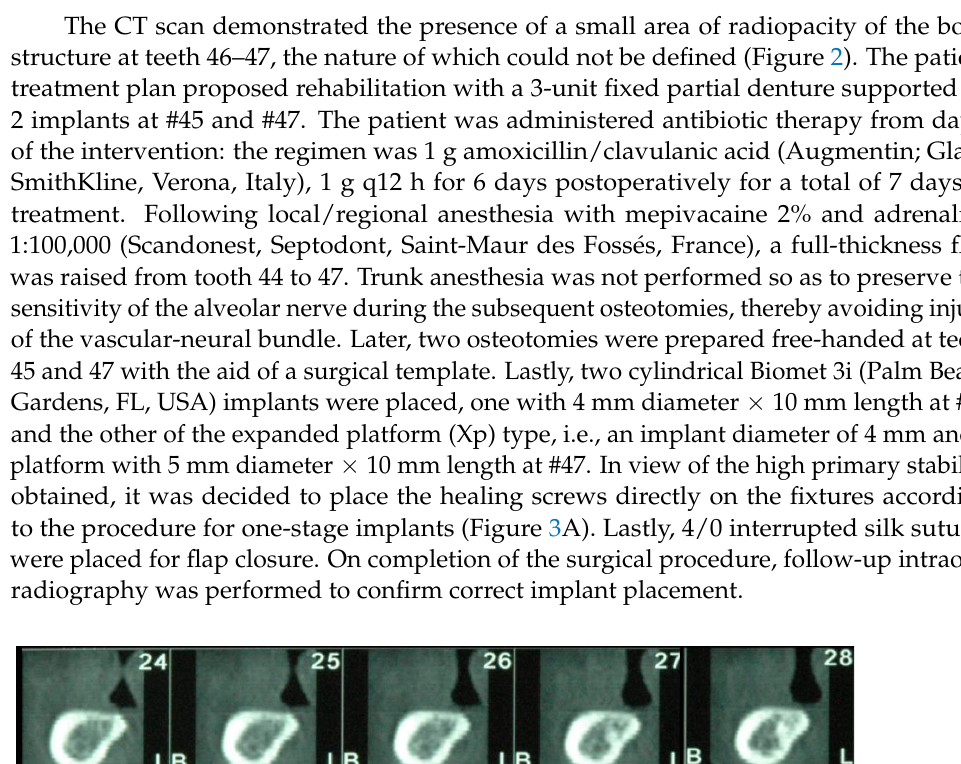
Figure 1. Preoperative intraoral radiograph of the edentulous area.